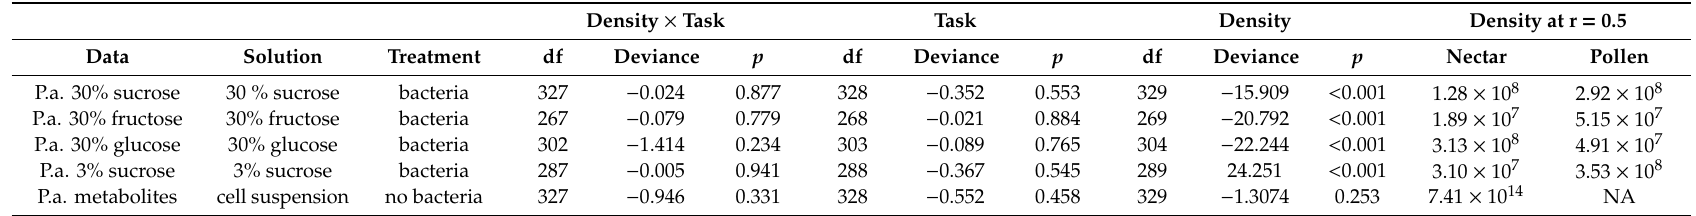
Table 1. E ff ect of bacterial density (D1 to D5) and honeybees’ task (nectar or pollen forager) on the probability of proboscis extension response (PER). For each experiment, the results of the generalized linear models are given, i.e., the e ff ect of density and task and the interaction between both explanatory variables. Significant e ff ects are highlighted in bold. Additionally, the estimated density of bacteria at r = 0.5, i.e., the density of bacteria that prevents 50% of honeybees from showing PER, is